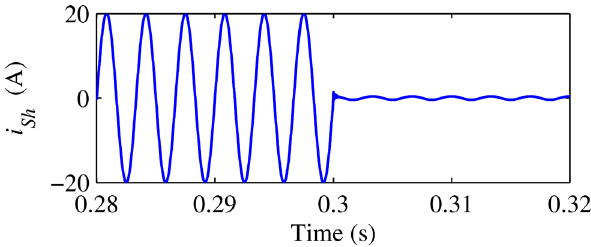
Fig 7. Performance of Improved R-APF algorithm With K Vh set to 0.95/ Z eqh